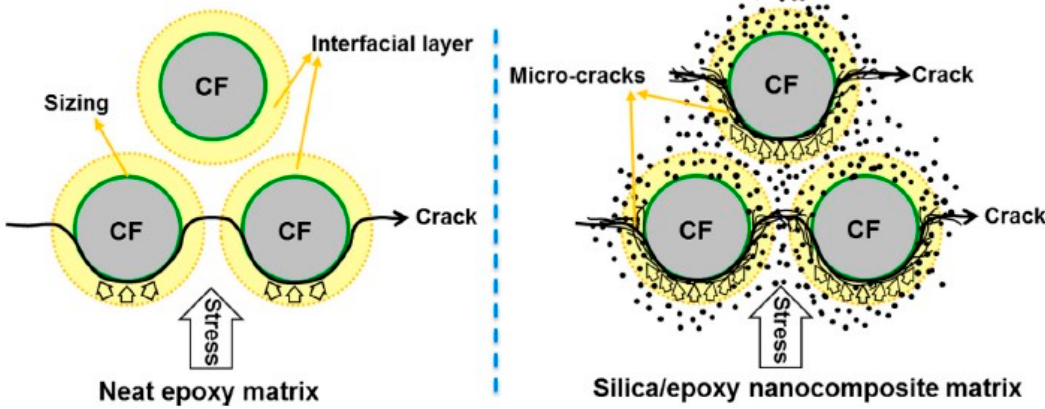
Figure 14. Schematic illustration of energy dissipation and stress transfer in the interphase layer of